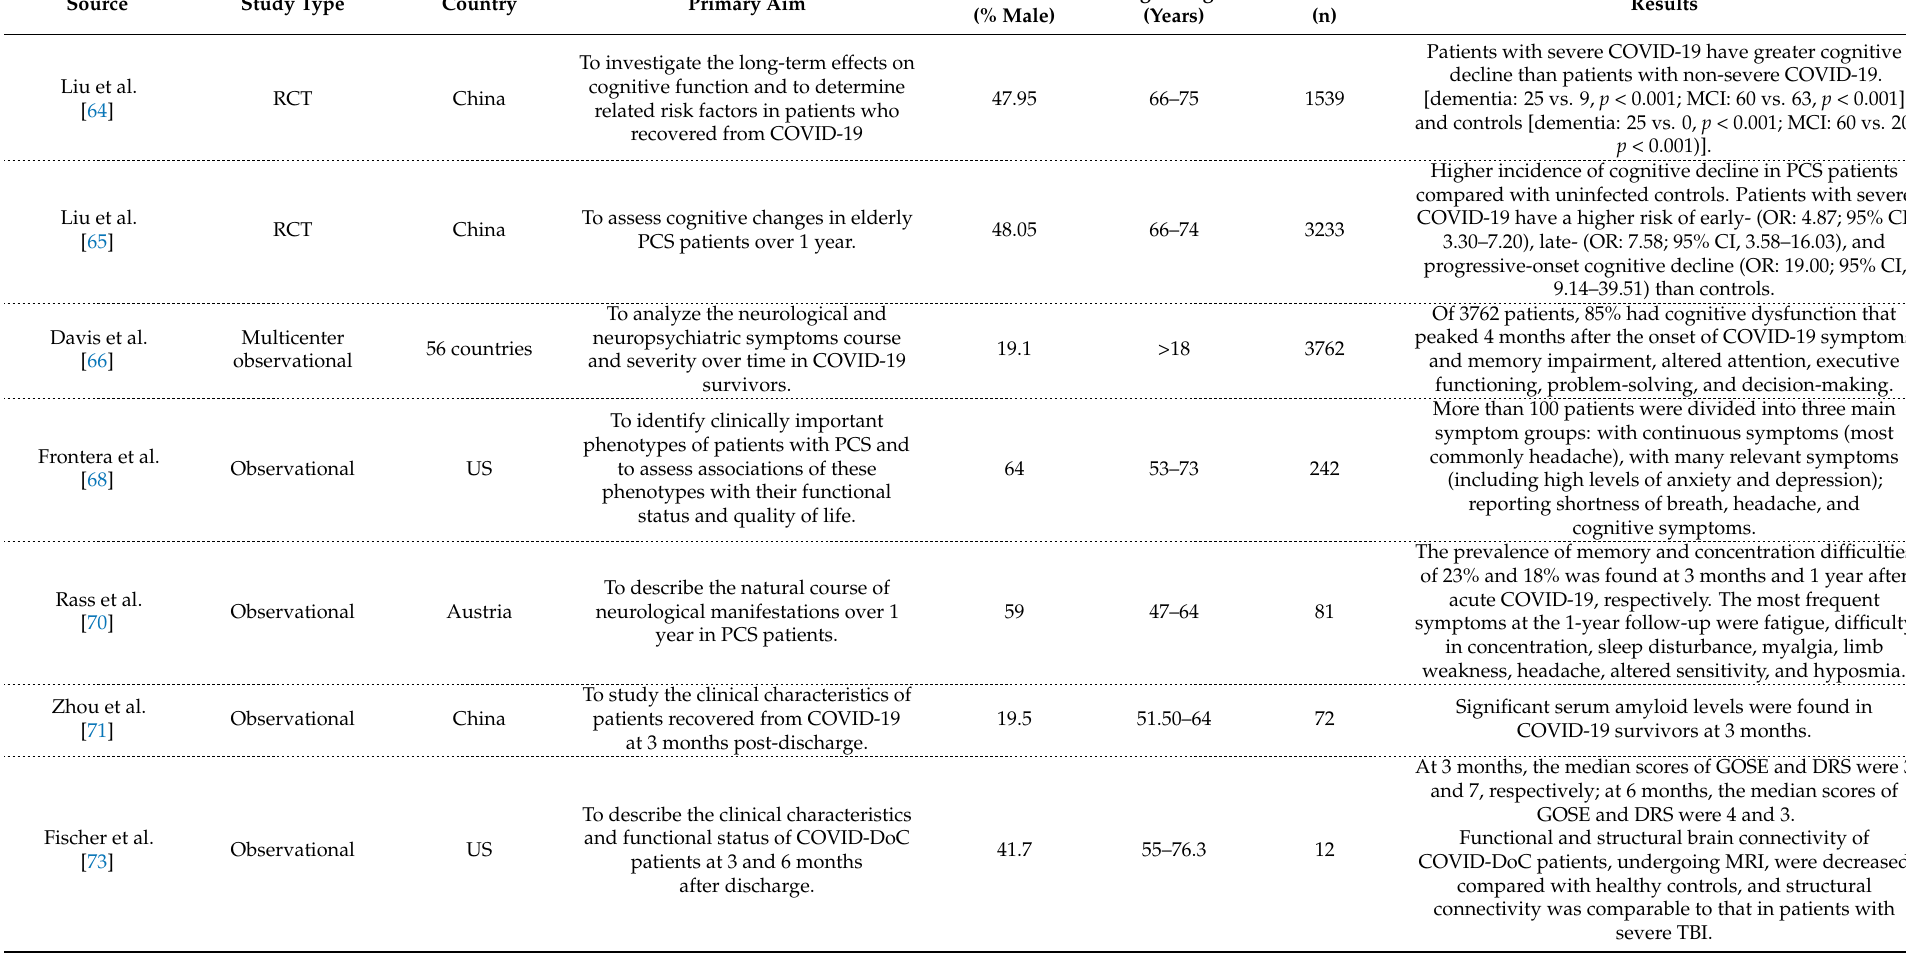
Table 3. Studies on long-COVID neurological and psychological